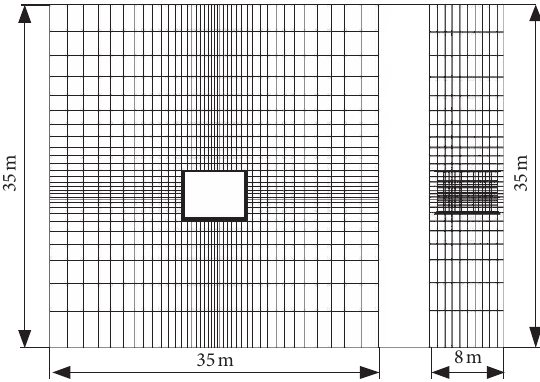
Figure 7: Schematic diagram of the 3D numerical